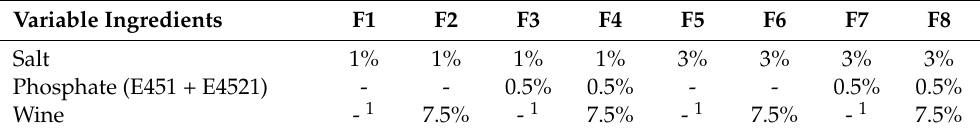
Table 1. Experimental